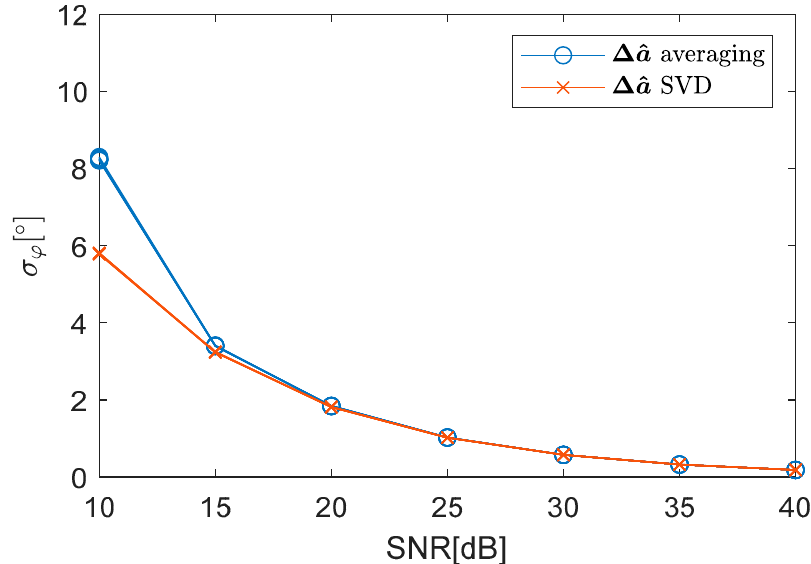
Figure 6. The standard deviation of phase for coefficients of vector Δ𝒂 (cid:3549) .